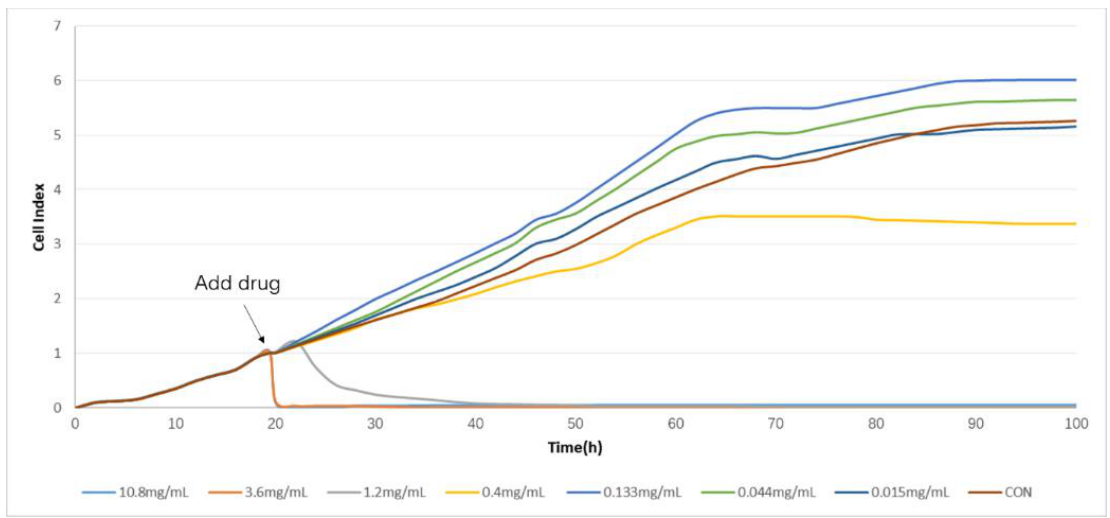
Figure 5. The time/dose-dependent cell response profiles (TCRPs) of the different concentration samples of CDDPs acting on MCF-7 cells plotted against time with the mean of three experiments. The concentrations are: 10.8 mg/mL (light blue line), 3.60 mg/mL (medium brown line), 1.20mg/mL (gray line), 0.400 mg/mL (yellow line), 0.133 mg/mL (medium blue line), 0.044 mg/mL (green line), 0.015 (dark blue line), and control (dark brown line).